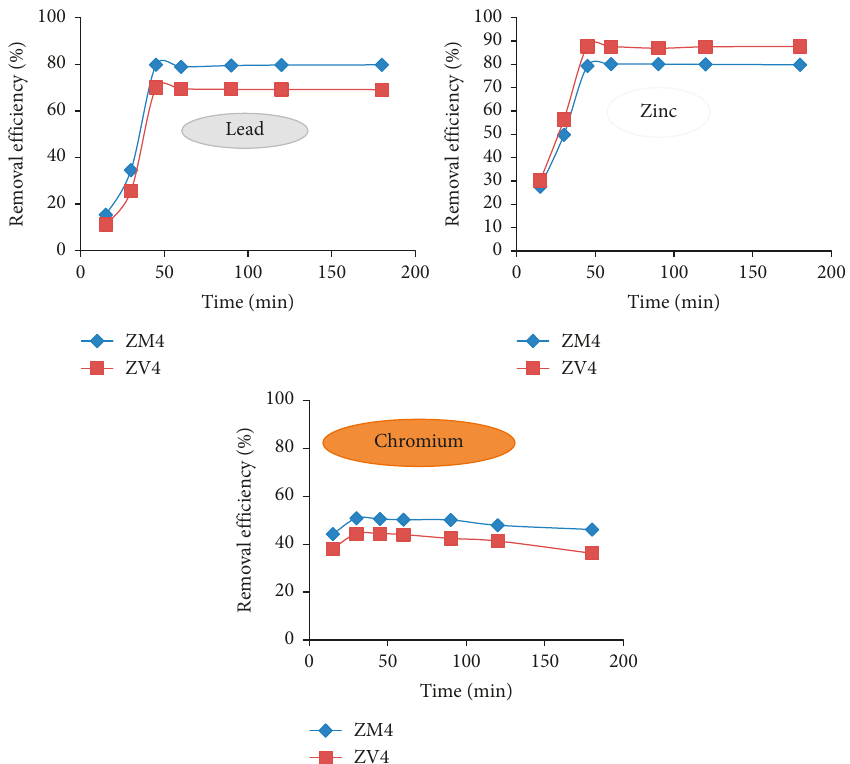
Figure 8: Effect of contact time on the removal of heavy metals by ZV4 and